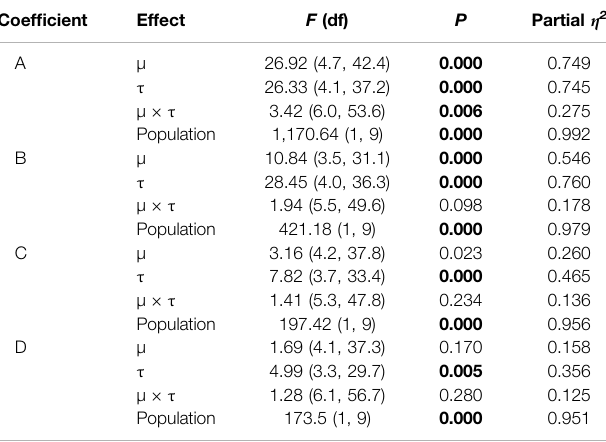
TABLE 1 | Adaptation over 100 generations of directional selection, statistical analysis of regression coef fi cients in four repeated-measures